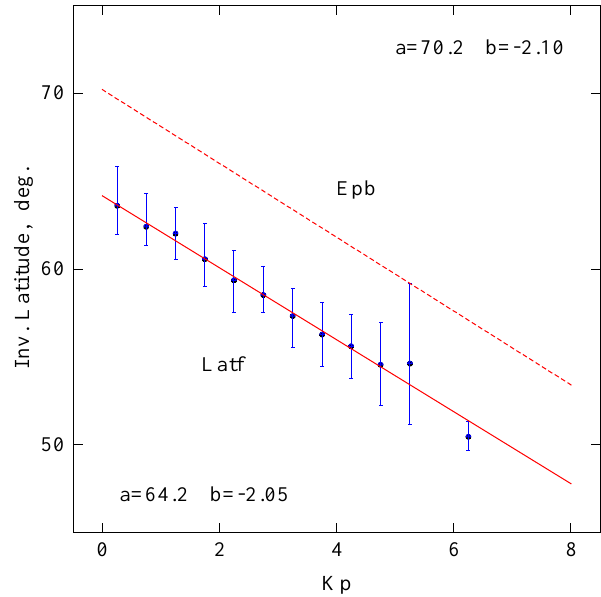
Fig. 14. Equatorward boundaries of the diffuse auroral electron pre- cipitation (Epb) and polar cliff (latf) as function of geomagnetic ac- tivity. The auroral precipitation data are taken from (Gussenhoven et al., 1981). Since these authors use the Kp index to describe the level of geomagnetic activity, our data were replotted